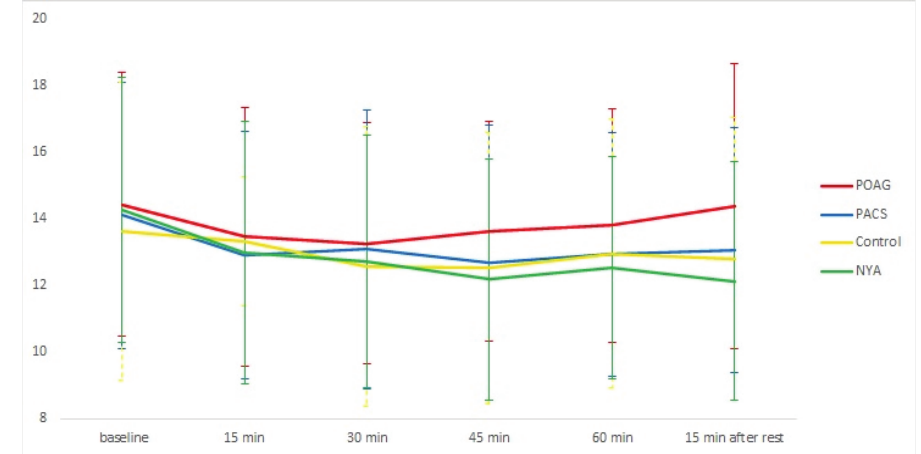
Figure 1. Changes in IOP between and within study groups throughout the study. Maximum IOP reduction was observed 30 min after a near task in POAG, 45 min after accommodation in PACS and control groups, and 15 min after the end of accommodation in NYA. POAG, primary open-angle glaucoma; PACS, primary angle-closure suspect; NYA, normal young